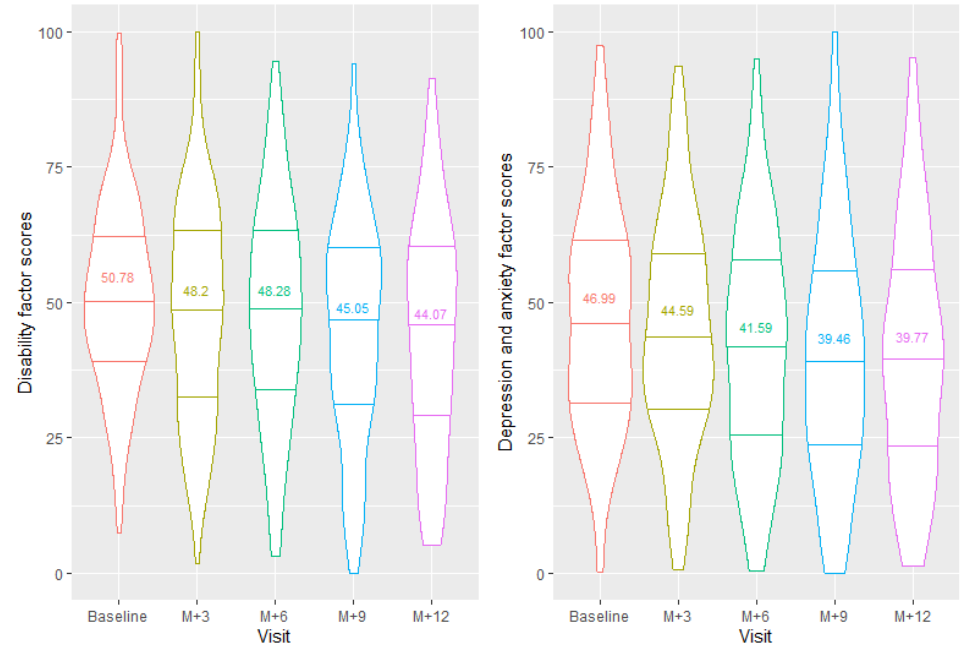
Figure 3. Violin plot of factor scores per visit of each construct. The lines represent the median and the first and third quartiles. The mean scores (/100) of each visit were also added to the plot. The violin plots show the distribution shape of the data at each visit. Wider sections of the violin plot represent a higher probability that patients will have the given score; thinner sections represent a lower